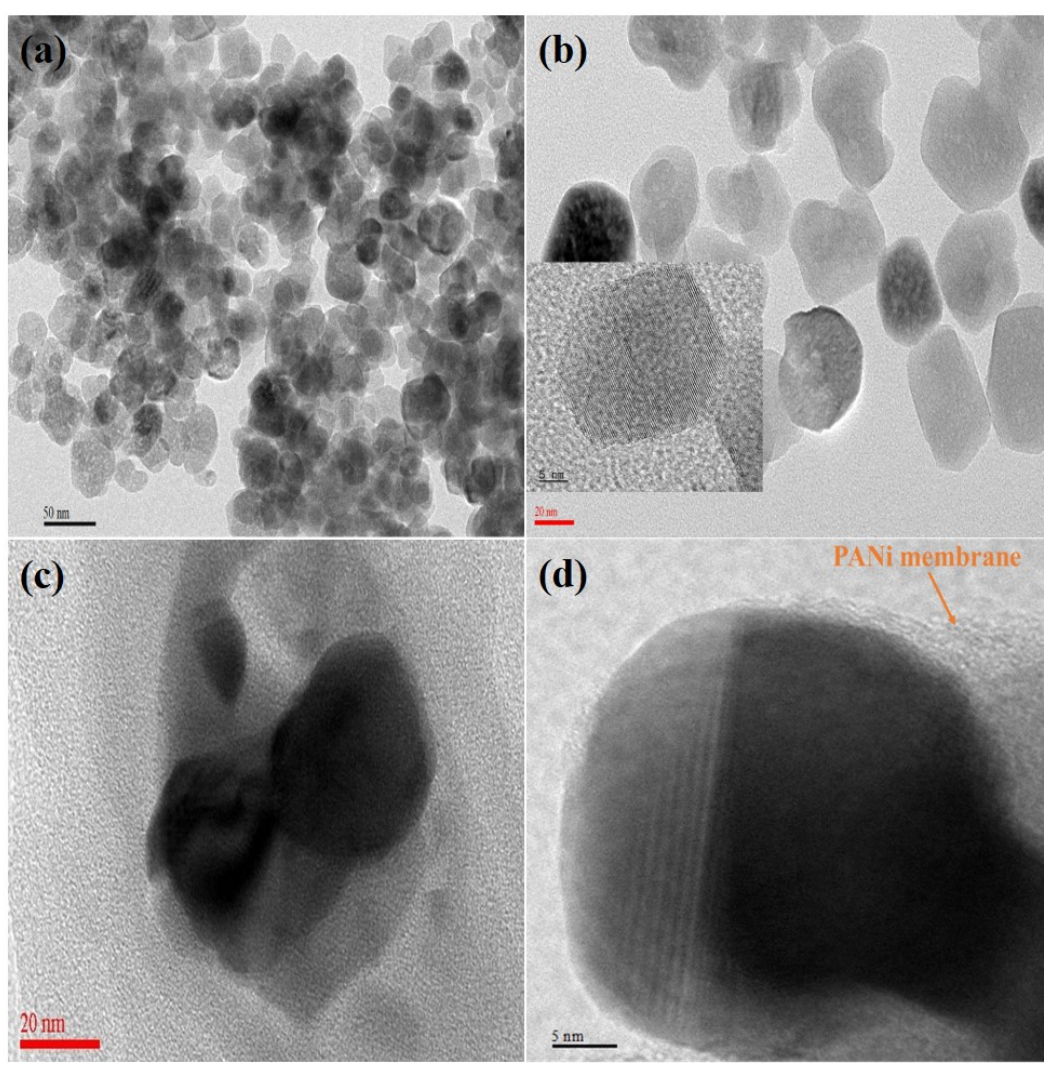
Figure 2. Morphological analysis, HRTEM image of ( a ) TiO 2 , ( b ) Mn-TiO 2 , ( c and d ) PANi/Mn-TiO 2 Morphological analysis, HRTEM image of ( a ) TiO 2 , ( b ) Mn-TiO 2 , ( c , d nanoparticles.